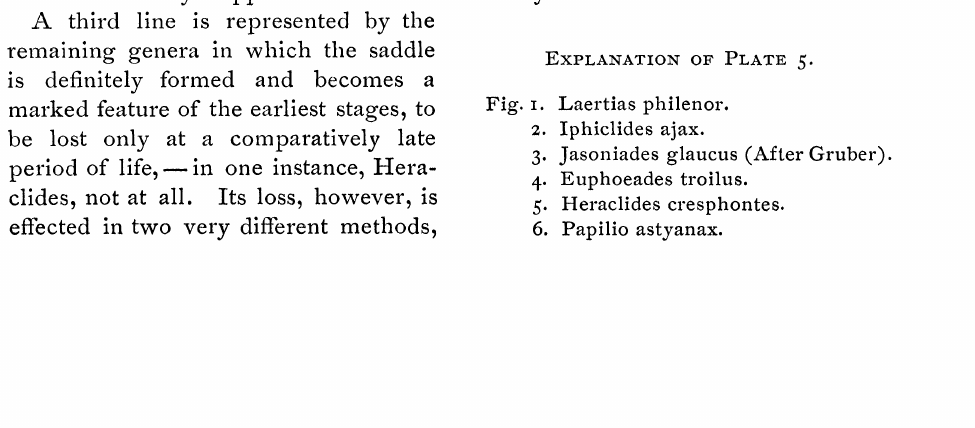
. Fig. I. Laertias philenor. Iphiclides